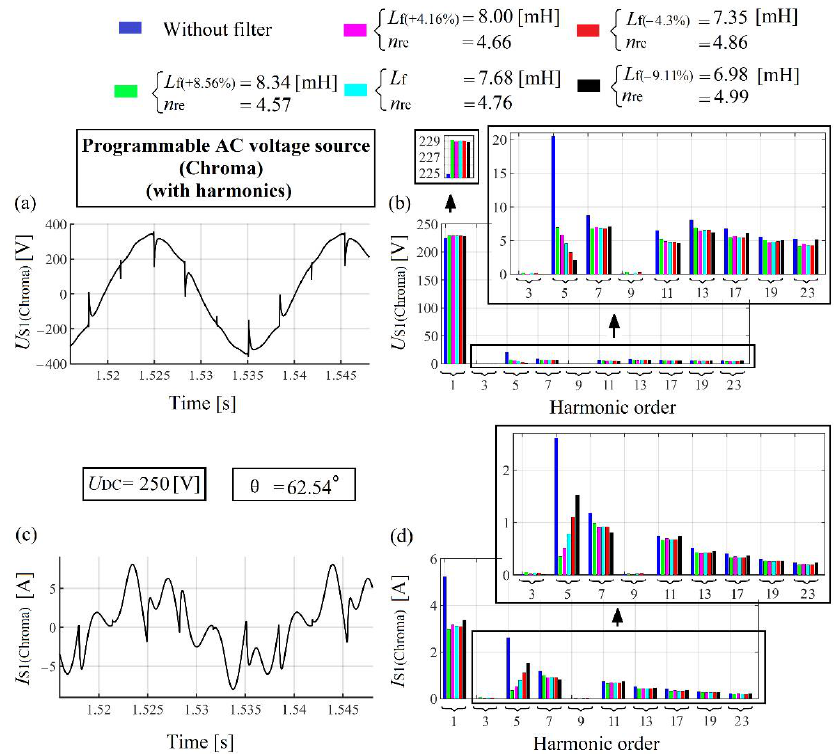
Figure 58. ( a ) PCC voltage waveform with ( b ) its spectrum, ( c ) Chroma input current with ( d ) its spectrum.